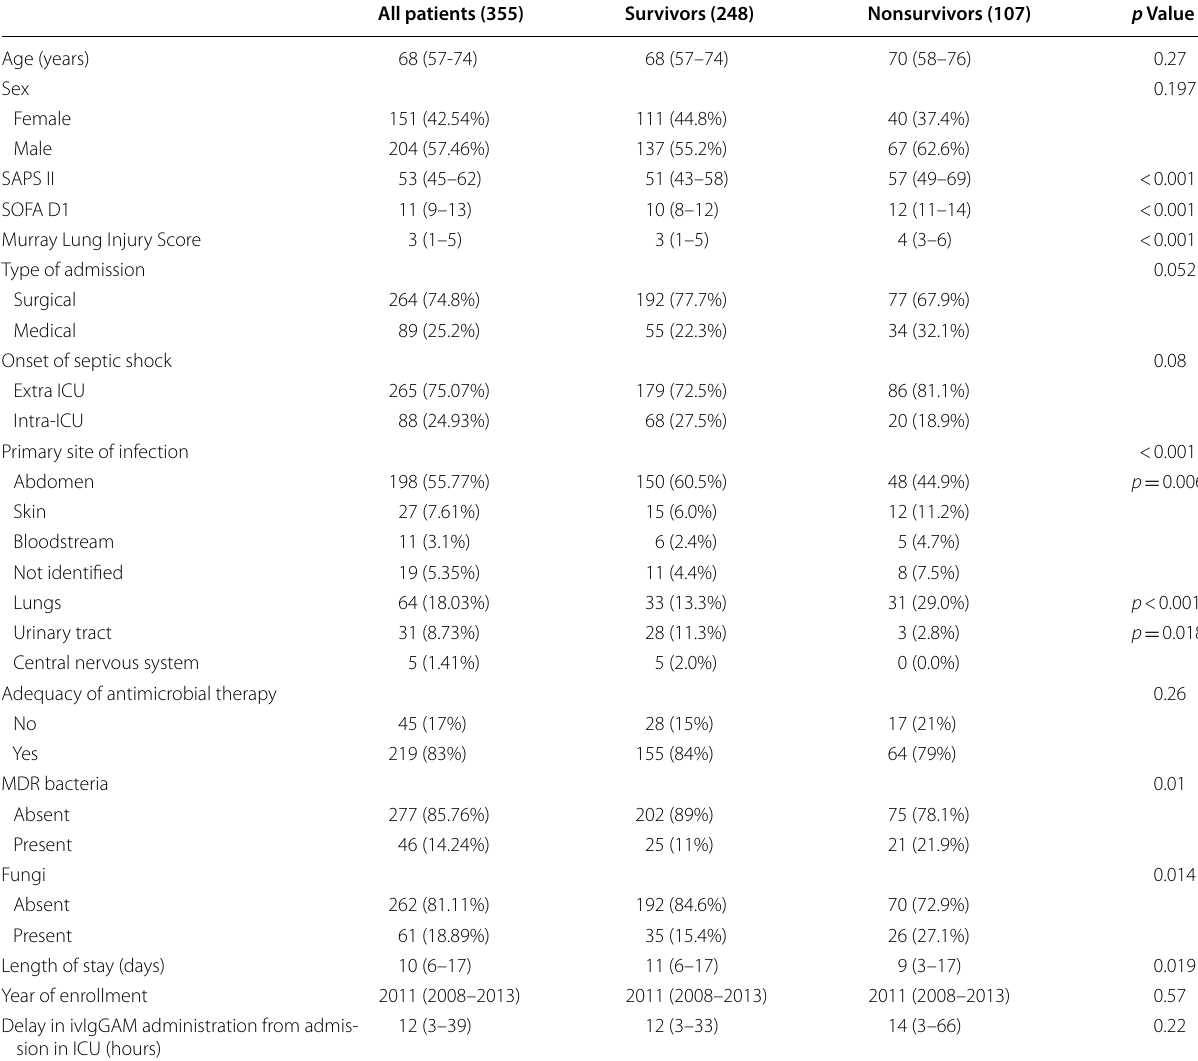
Table 1 Characteristics of the studied patients subdivided into Survivors and Nonsurvivors at discharge from ICU